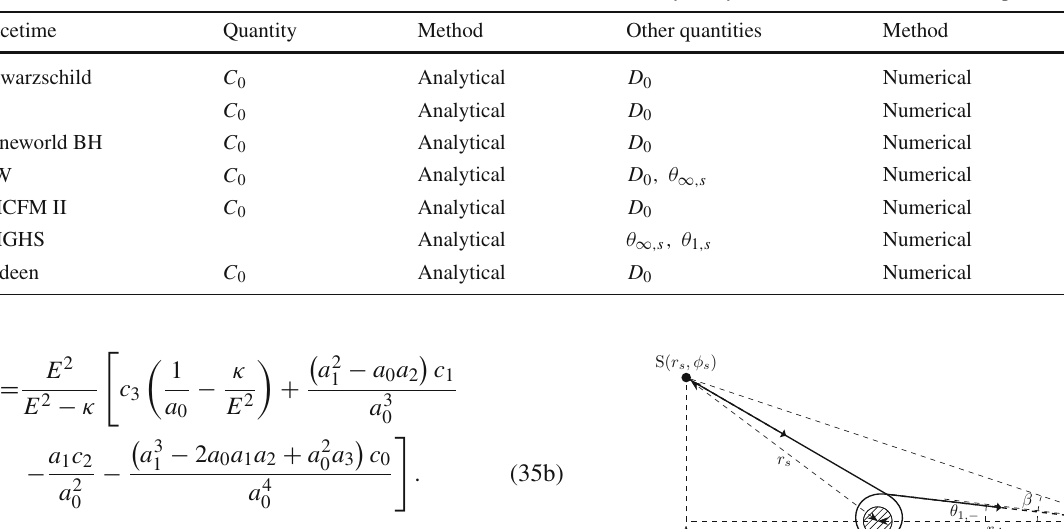
the Janis–Newman–Winicour, Germani–Maartens–Casadio–Fabbri– Mazzacurati and Gibbons–Maeda–Garfifinkle–Horowitz–Strominger spacetimes respectively. See Eq. (39) for meaning of θ n , s . Also note that for simplest spacetimes, Ref. [41] and Ref. [21] were able to compute